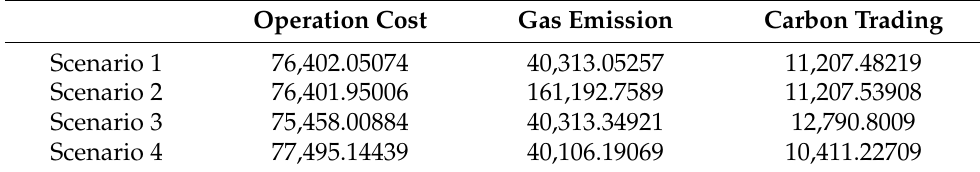
Table 4 lists the four optimal energy management solutions of the scenarios. Table 4. Results of the comparison scenarios.